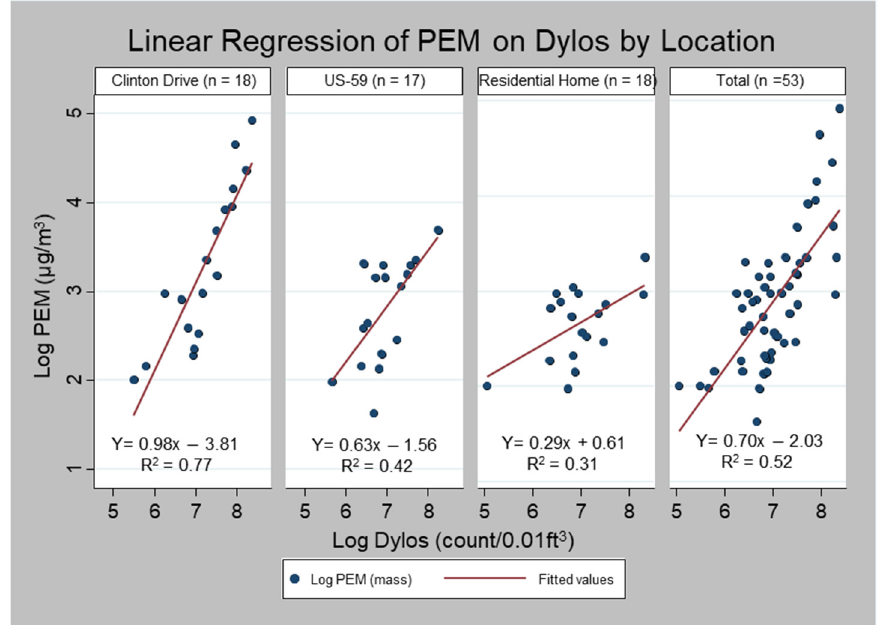
Figure 3. Linear regression of Dylos on PEM PM 2.5 measurements by sampling location.